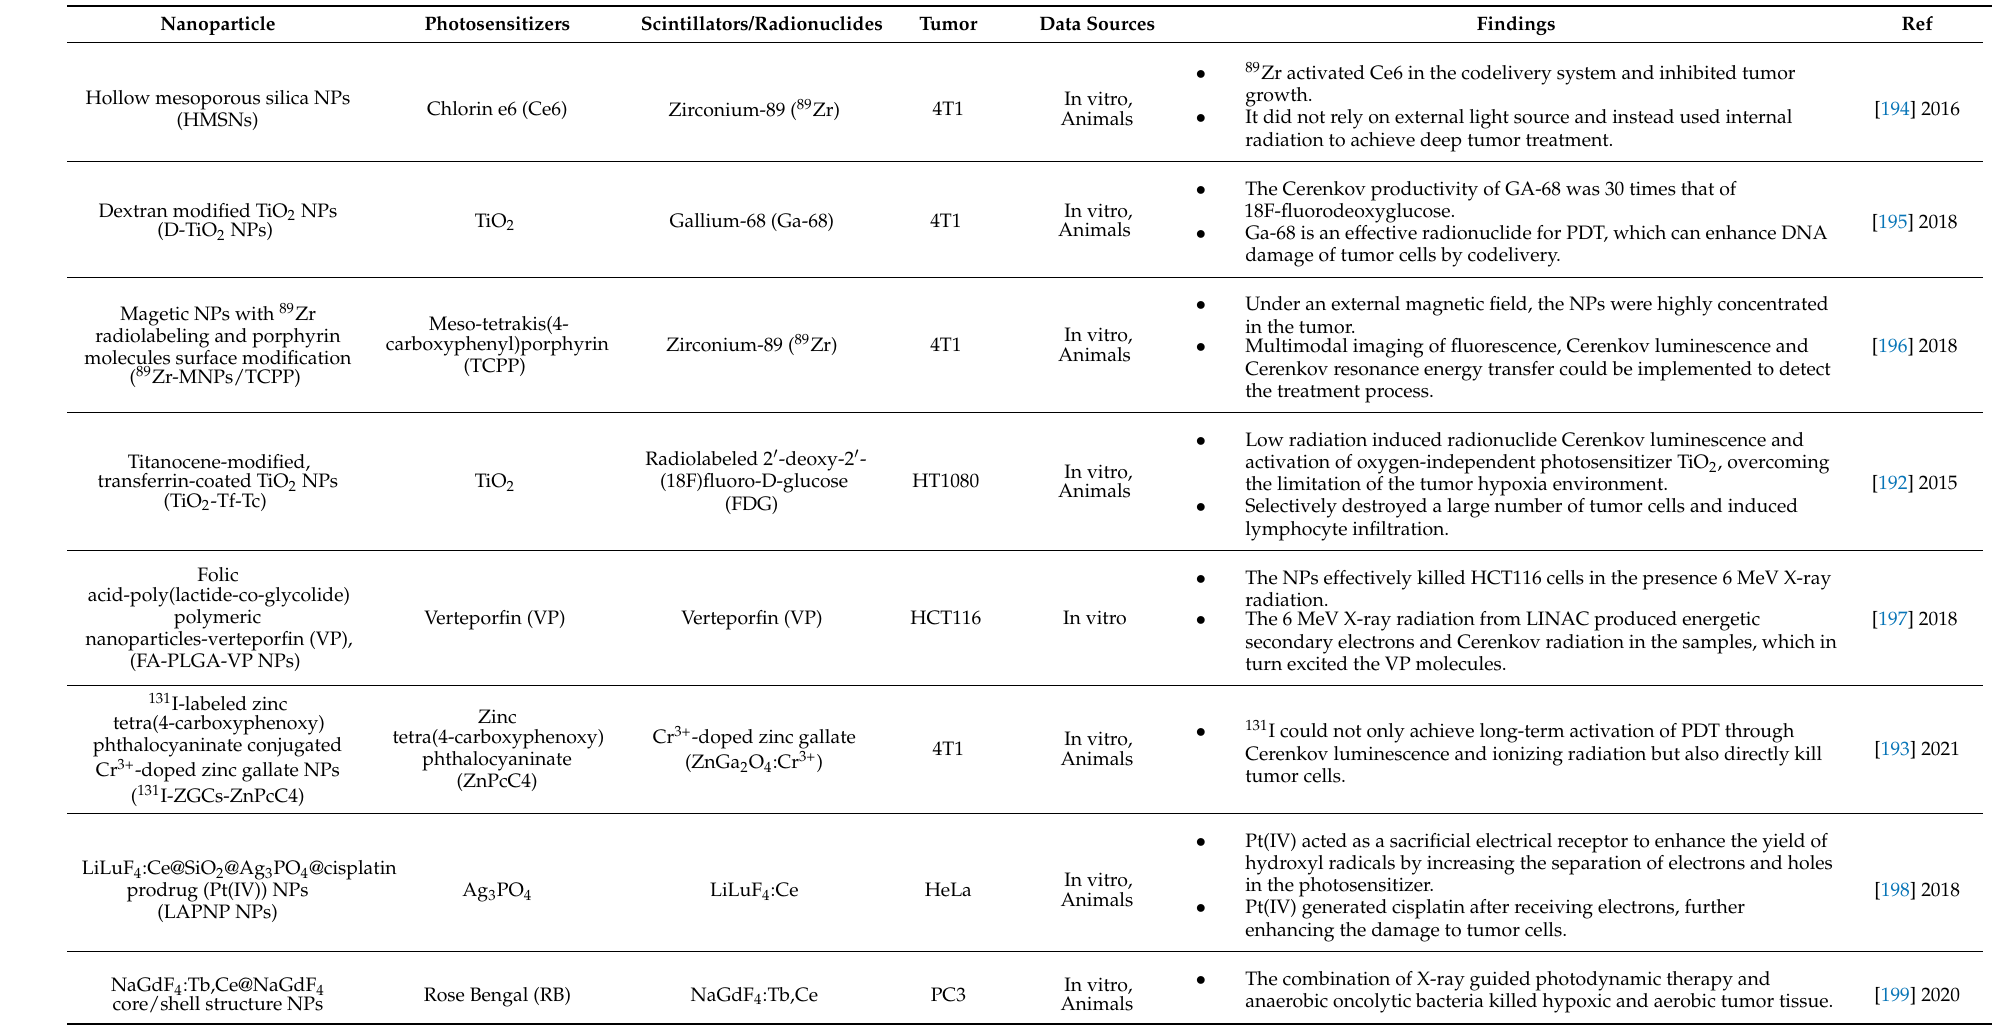
Table 6. Codelivery of photosensitizers and scintillators/radionuclides based on